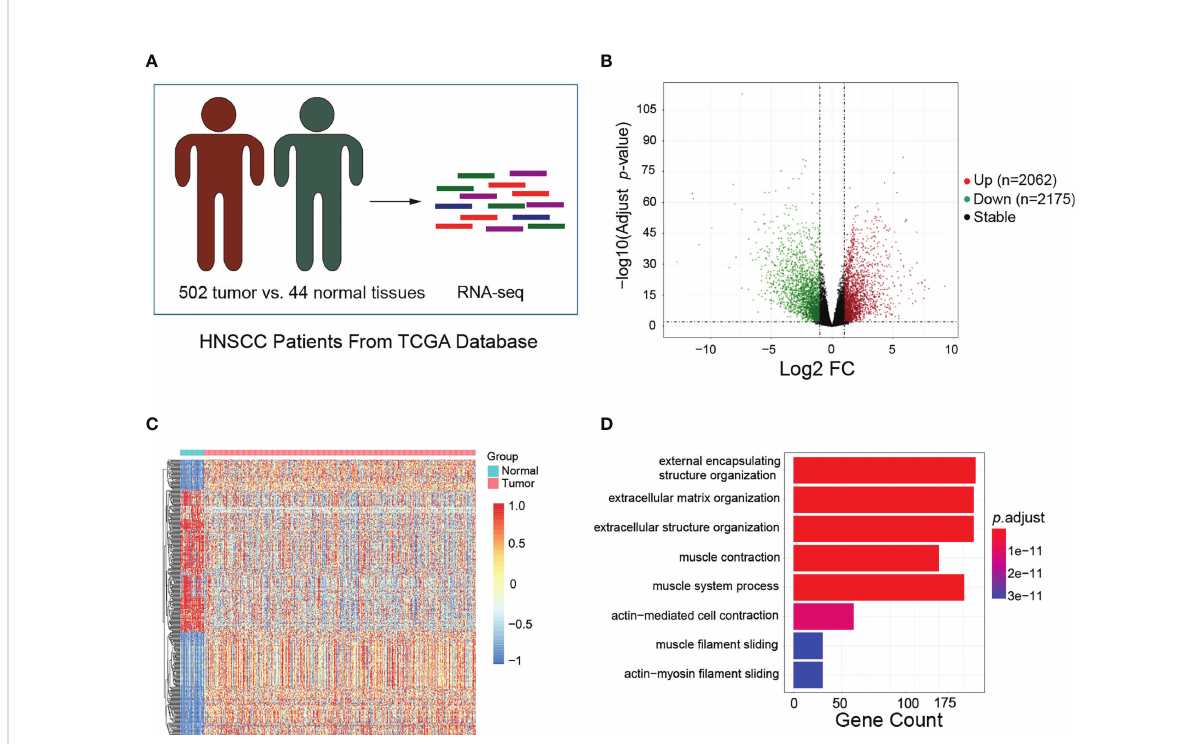
FIGURE 1 Identi fi cation of differentially expressed genes (DEGs) and enriched biological processes in head and neck squamous cell carcinoma (HNSCC). (A) Schematic of the patient samples included in the RNA sequencing (RNA-Seq). (B) Volcano plots showing the fold change (FC) and p -values for the comparisons of tumor tissues and normal tissues. Upregulated (log2FC ≥ 1, p < 0.05) and downregulated (log2FC ≤ − 1, p < 0.05) genes are depicted in red and green , respectively. (C) Top 200 DEGs between tumor and normal tissues visualized as heatmaps from RNA-Seq. Data were z -score normalized. (D) Gene Ontology enrichment analysis for the top 200 DEGs between tumor and normal tissues. Only the signi fi cant enrichment values ( p < 0.05) of the GO terms from the biological process category are